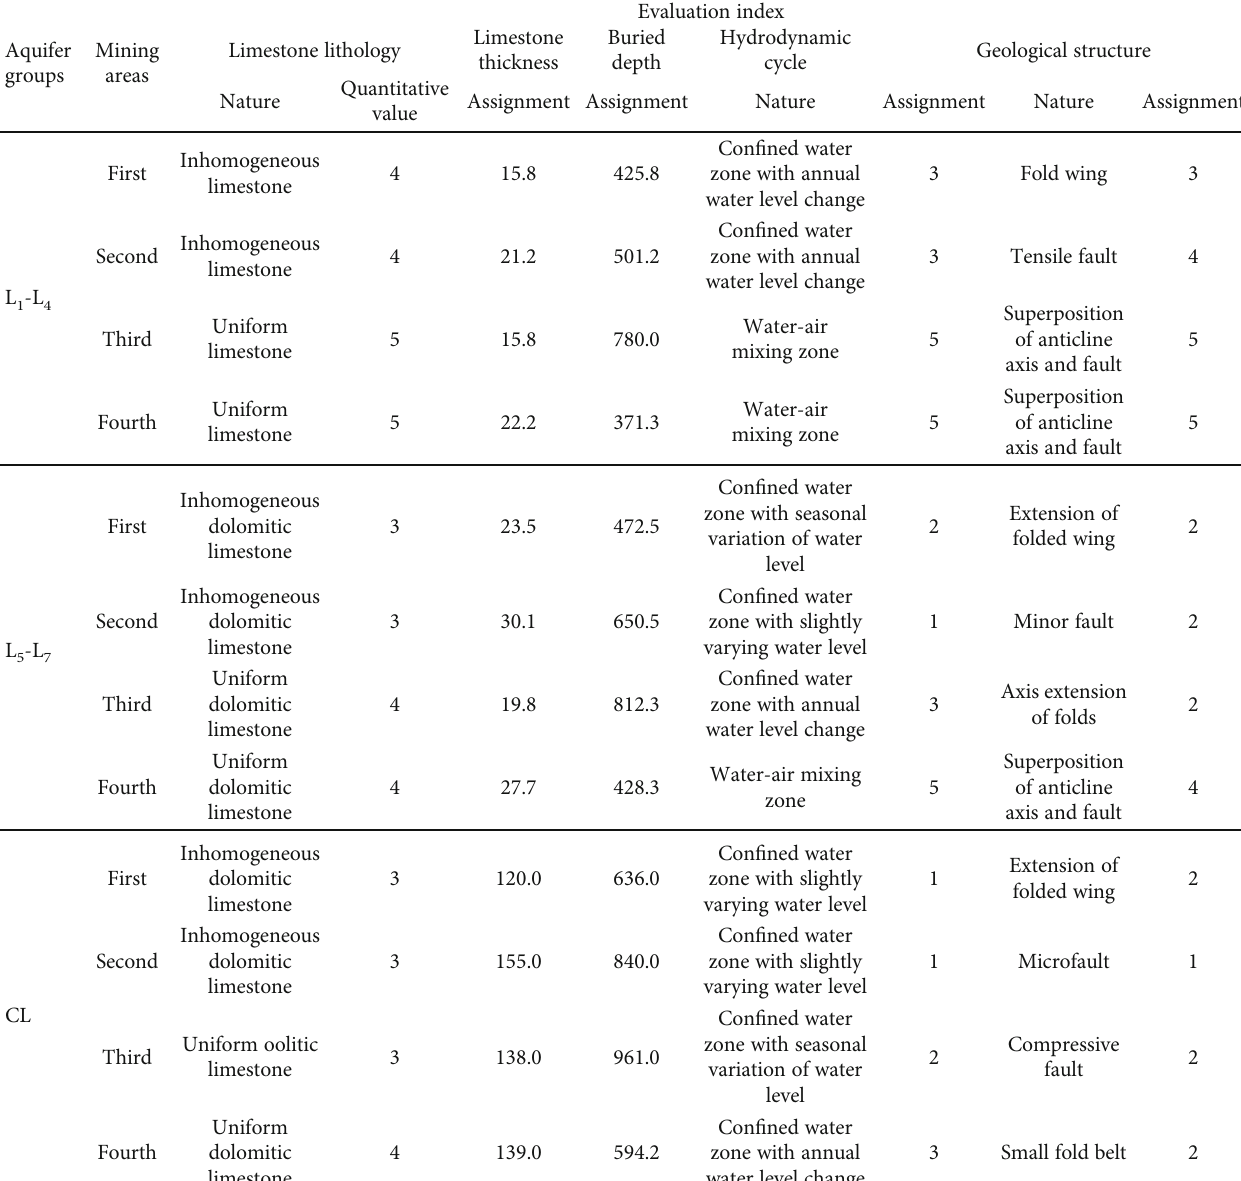
Table 5: Quantitative evaluation index values for the degree of karst development.